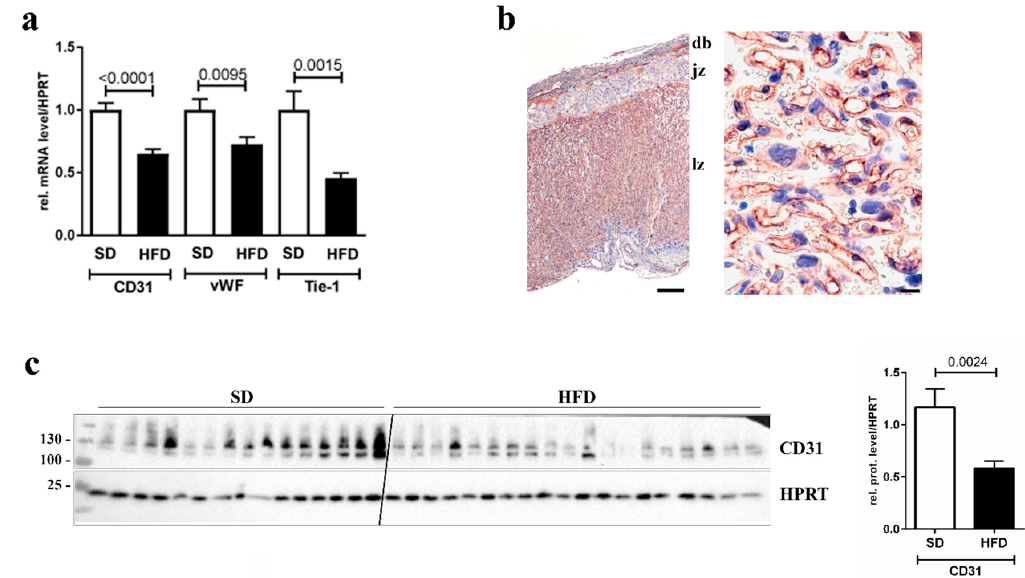
Figure 1. E ff ect of high fat diet (HFD) on placental endothelial cell markers. ( a ) qPCR analysis of endothelial cell markers CD31, von Willebrandt factor (vWF), and Tie-1, normalized to hypoxanthine-guanine phosphoribosyltransferase (HPRT), in whole placenta lysates of control (SD) and obese (HFD) mice. The p -value is indicated in the graph. n = 21 placentas from five dams for SD and n = 21 placentas from six dams for HFD. ( b ) A representative immunohistochemical staining of CD31 in a control (SD) placenta. Left image: Overview of a section through a whole placenta; note that CD31 is mainly located in the labyrinth zone (lz), not in the junctional zone (jz) or the decidua basalis (db). Scale bar 200 µ m. Right image: Magnification of the lz; note that CD31 is located in fetal capillaries. Scale bar 10 µ m. ( c ) Western blot analysis of CD31 in whole placenta lysates of SD and HFD mice. HPRT was detected for normalization. Both bands in the images were quantified by densitometry and the relative amount of CD31 / HPRT in the two groups is indicated in the bar graph next to the western blot. The p -value is indicated in the graph above the bars. n = 15 placentas from five dams for SD and n = 19 placentas from seven dams for HFD.